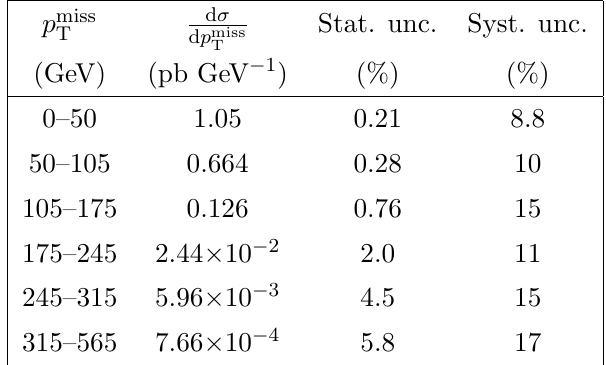
Table 14 . Results of the absolute di(cid:11)erential cross sections with relative uncertainties in the combined channel with respect to p miss T